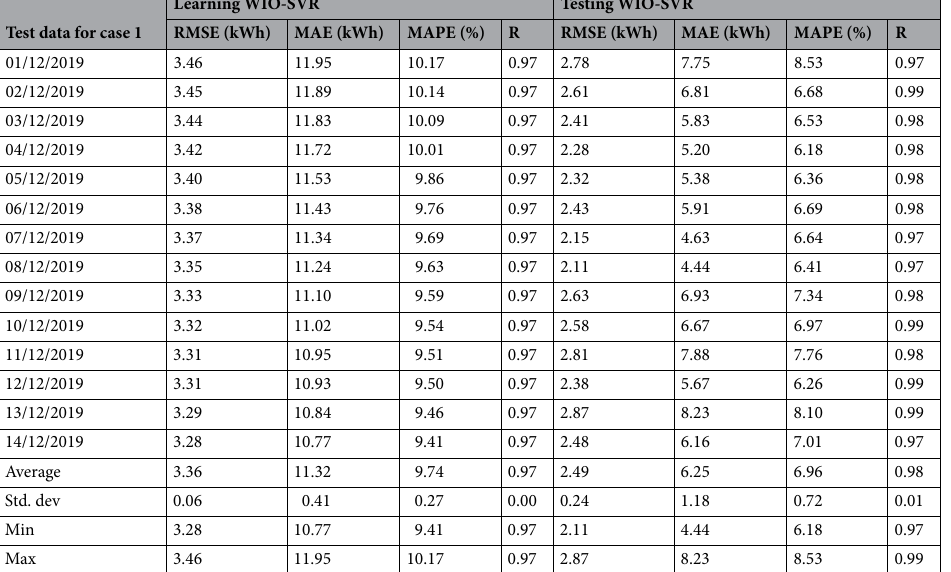
Table 2. Case study 1—evaluation